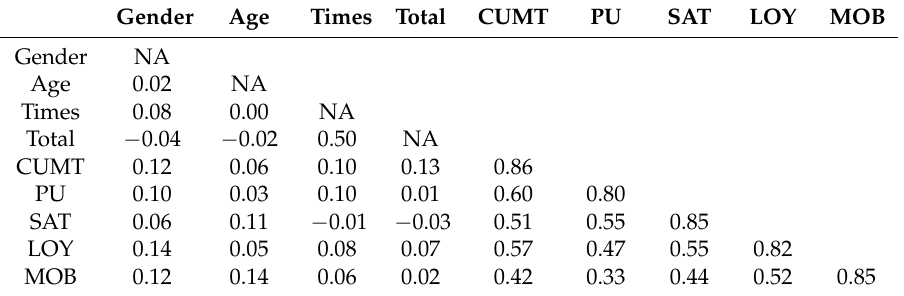
Table 5. Results of discriminant